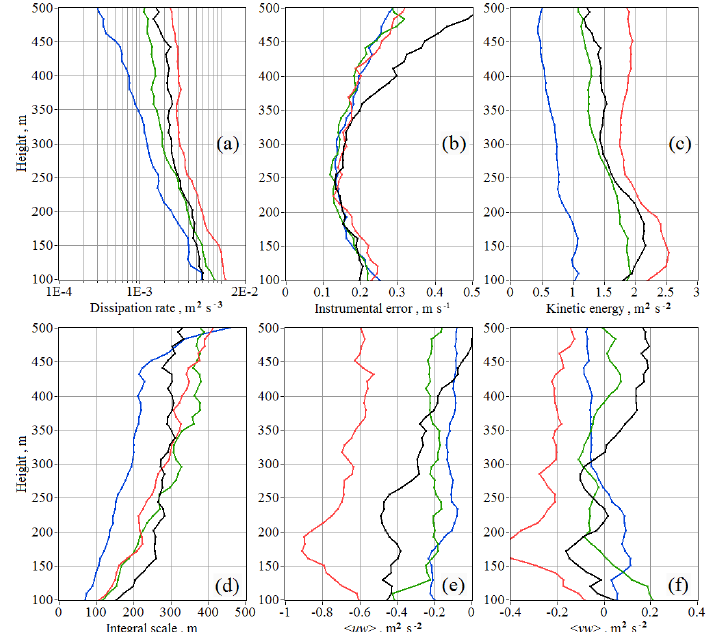
Figure 9. Vertical profiles of the turbulent energy dissipation rate ε (a) , instrumental error of radial velocity estimate σ e (b) , kinetic energy of turbulence E (c) , integral scale of turbulence L V (d) , and momentum fluxes < uw > (e) and < vw > (f) at 11:30LT (black curves), 14:00LT (red curves), 17:00LT (green curves), and 19:30LT (blue curves) taken from the data of Fig.